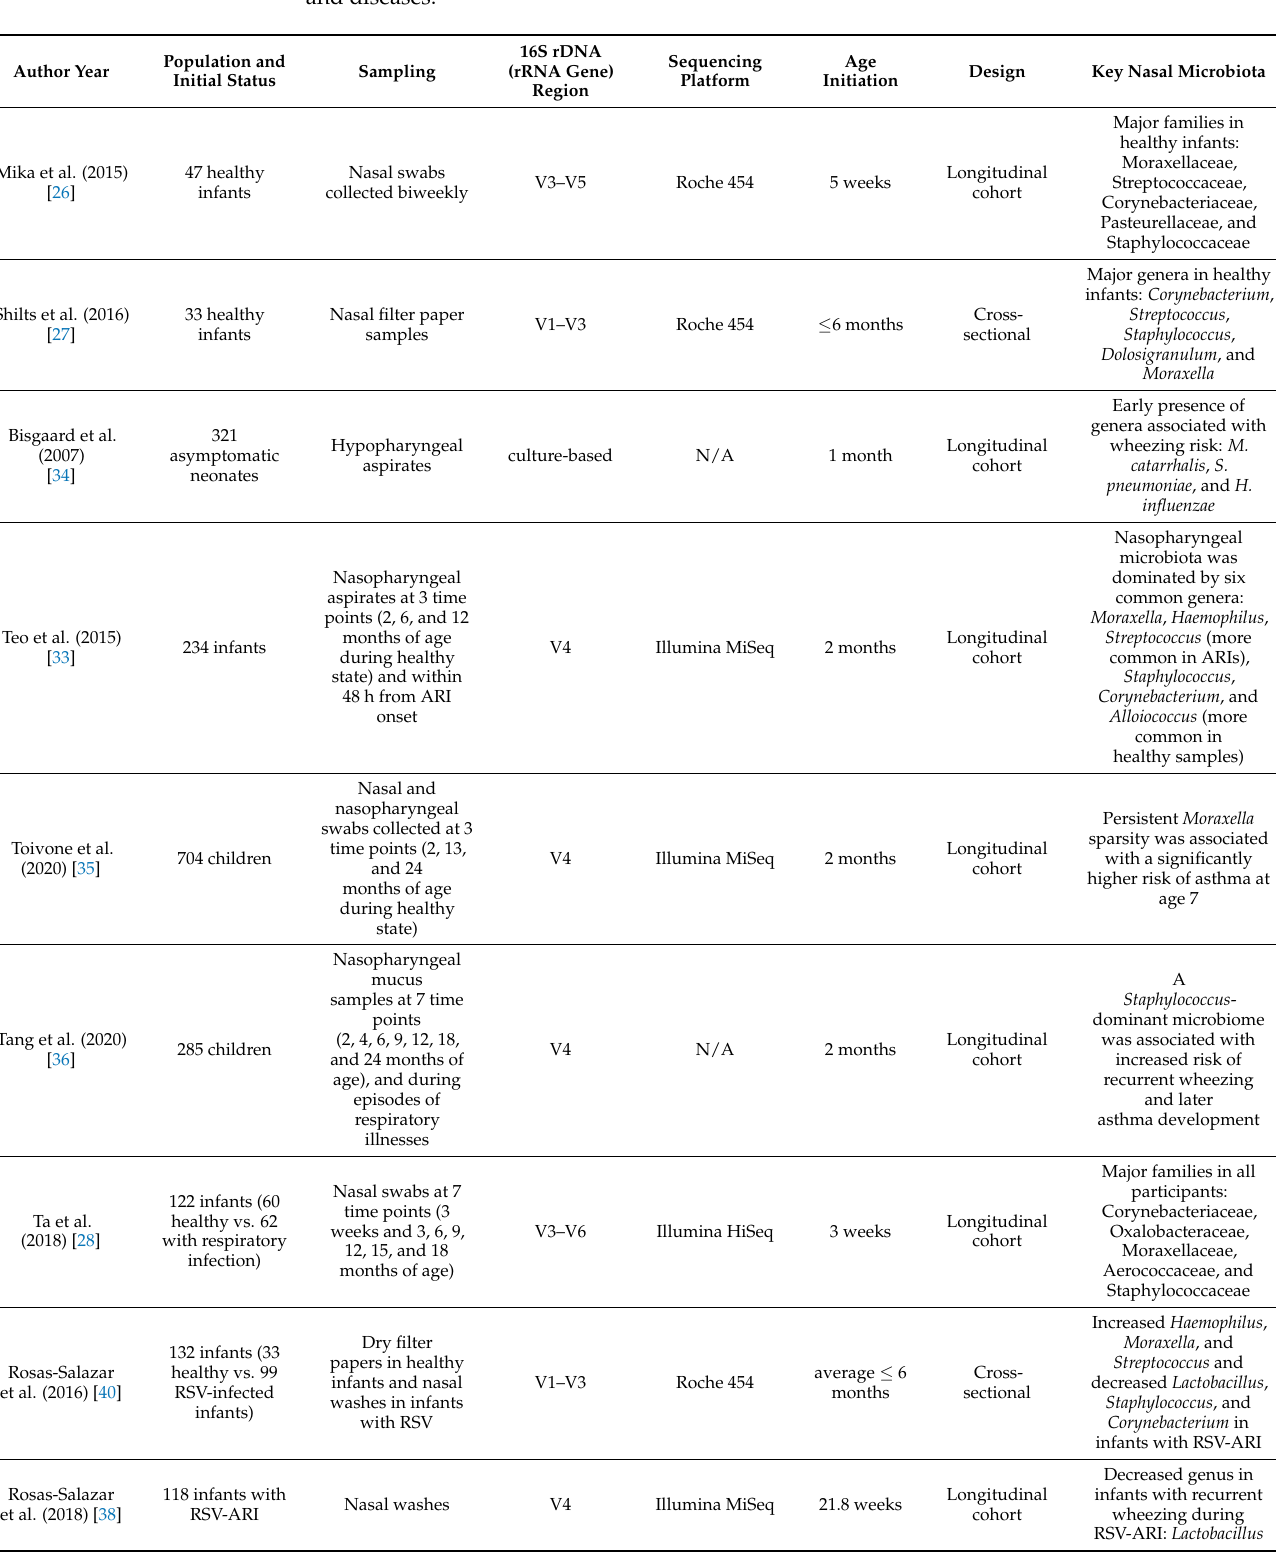
Table 1. Summary of the current findings on the association of nasal microbiota with health and